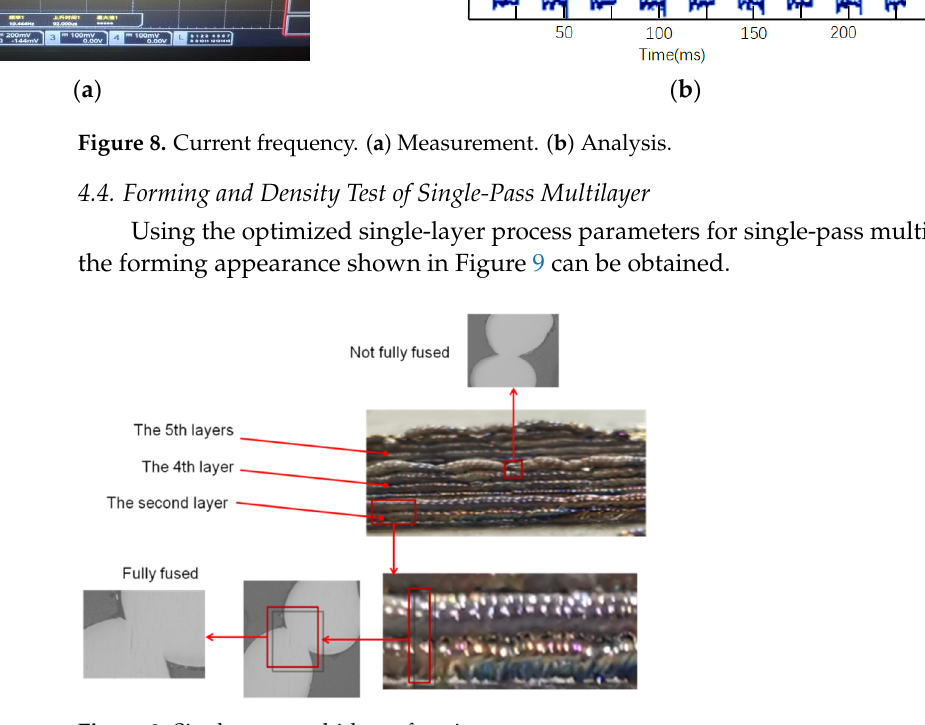
Figure 9. Single pass multi-layer forming.